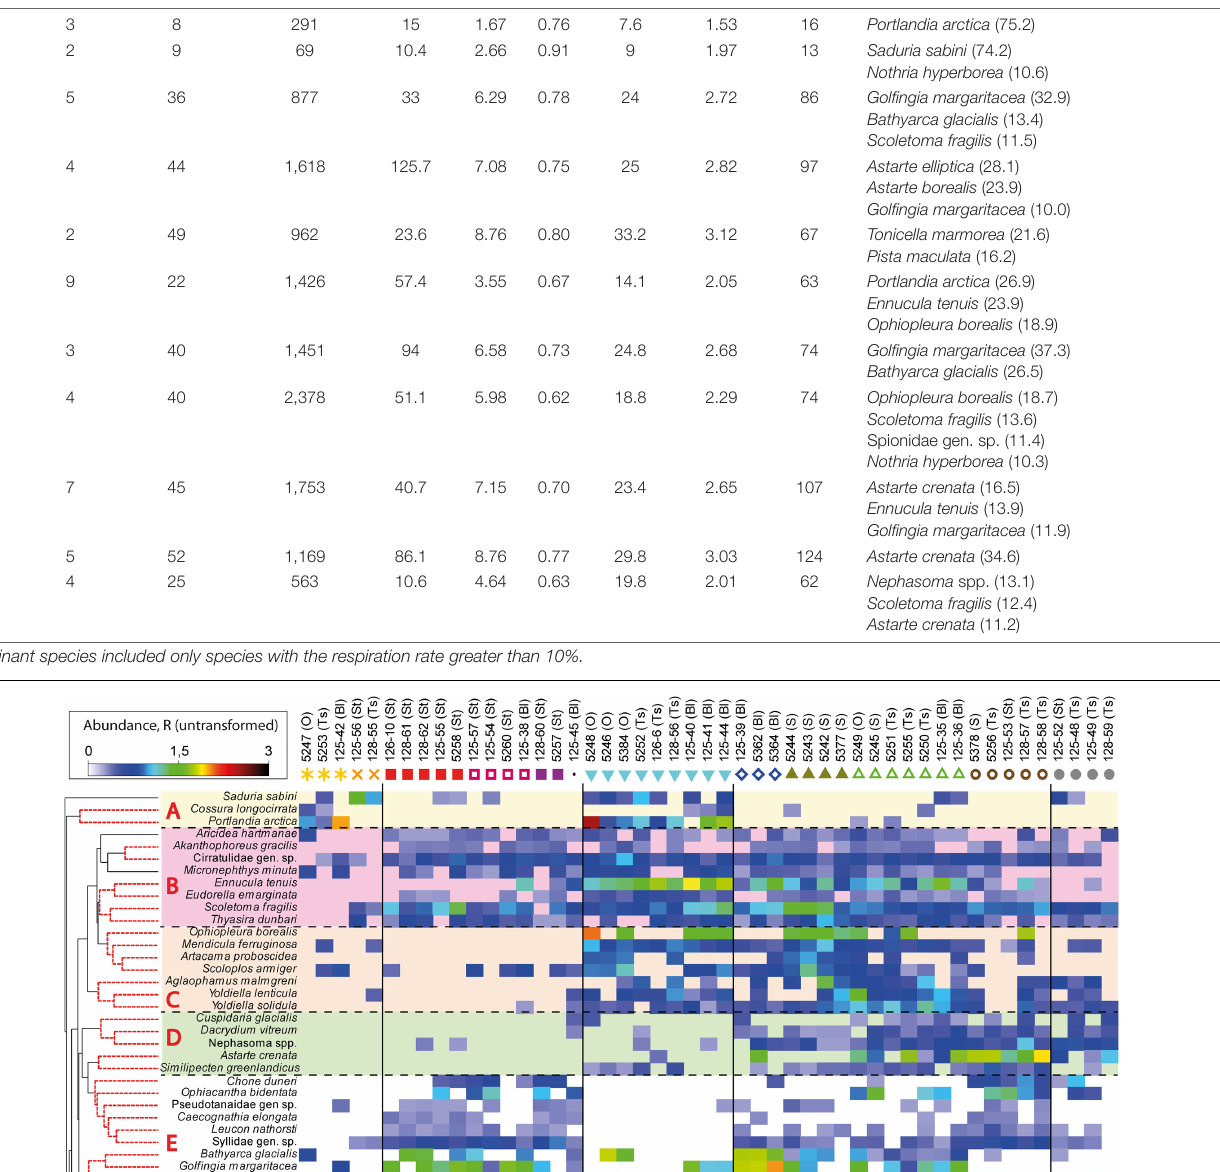
TABLE 2 | Summary of the characteristics of the identified clusters. Cluster